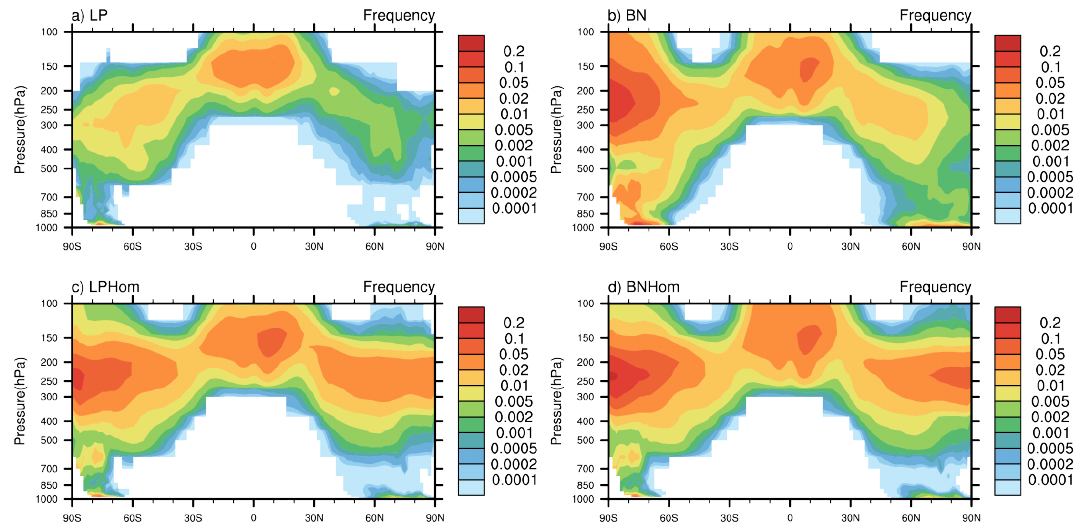
Fig. 3. Frequency distribution of homogeneous nucleation occurrence events in CAM5 for combined homogeneous and heterogeneous nucleation case (upper) and pure homogeneous nucleation case (lower) with LP05 (left) and BN09 (right) parameterizations.